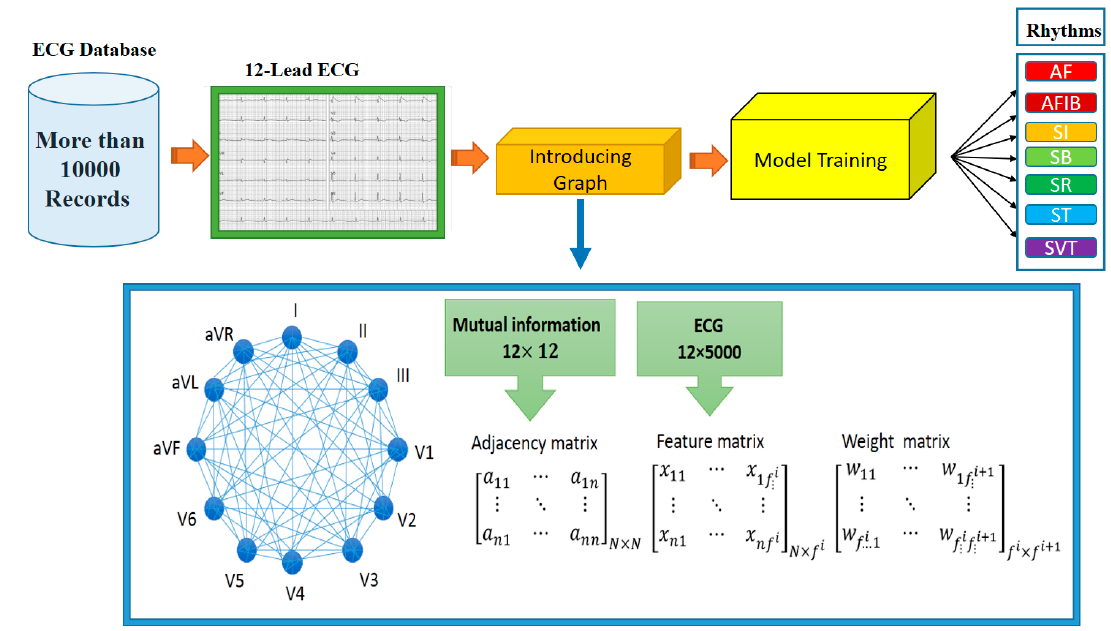
Figure 4. The proposed methodology and required materials for this study.